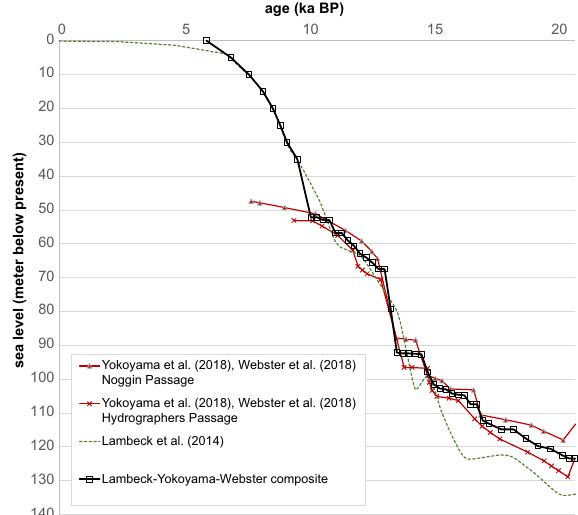
Figure 5. Composite sea level curve: constructed based on data in Lambeck et al. 39 and Webster et al. 21 , Yokoyama et al. 31 . This sea-level curve was used to translate between past sea levels and geological time, allowing a possible temporal reconstruction of the CaCO 3 deposition trends in the shelf edge of the GBR.